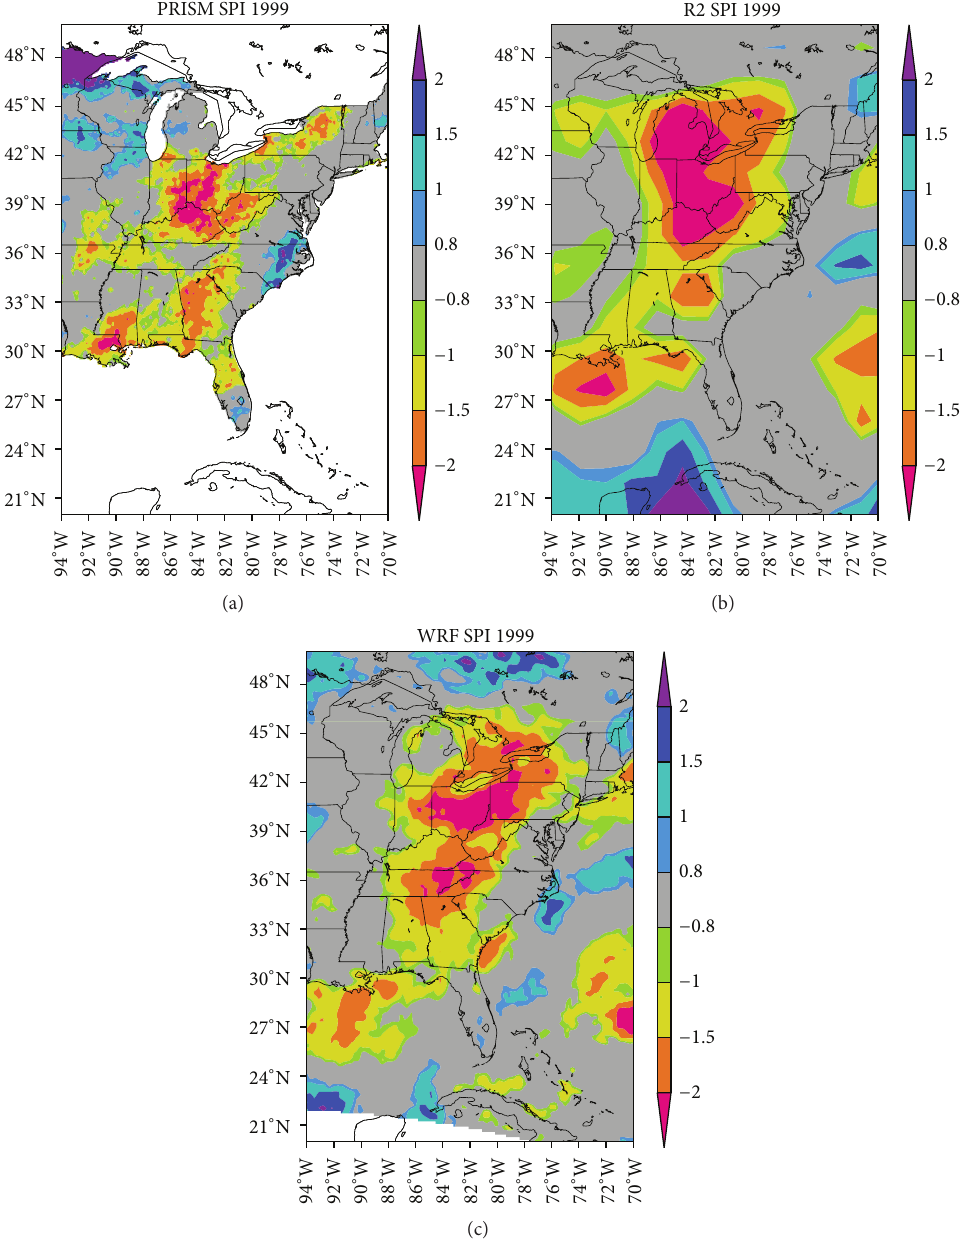
Figure 10: As in Figure 9, but for the period ending in September